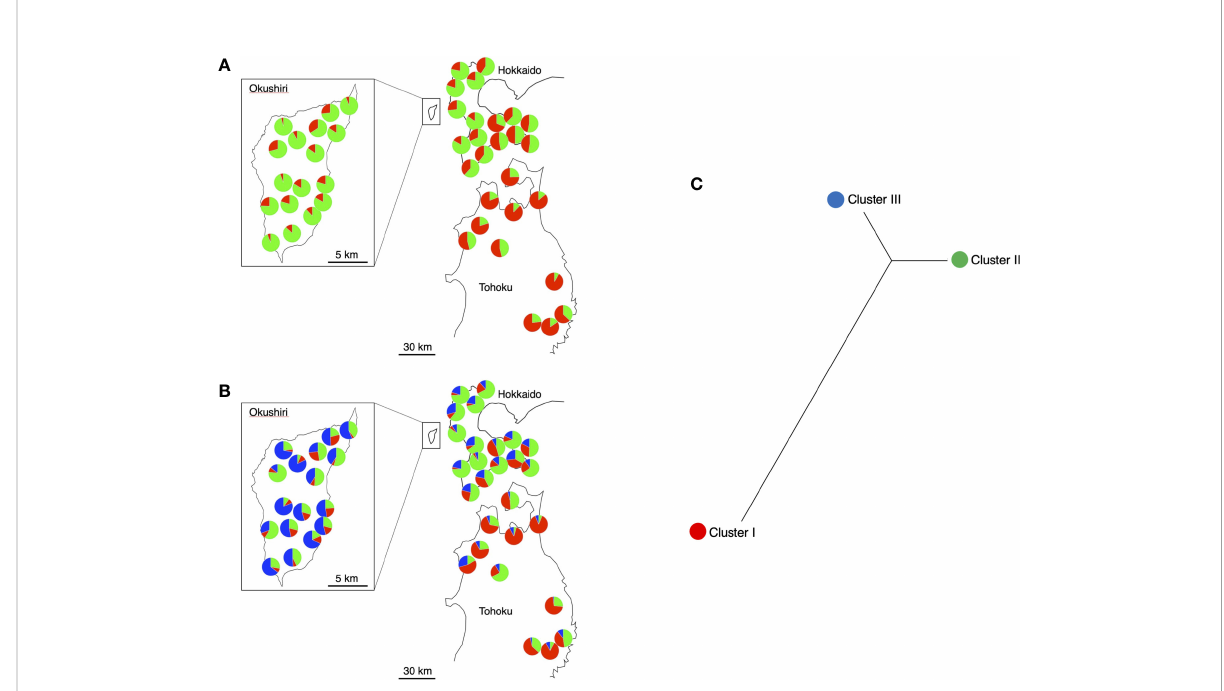
FIGURE 5 Pie diagrams of STRUCTURE results. The different colors indicate the different ancestral clusters. (A) K = 2, red and green indicate Cluster I and II, respectively. (B) K = 3, red, green, and blue indicate Cluster I, II, and III, respectively. (C) Relationships among the 3 clusters in K = 3 based on F ST